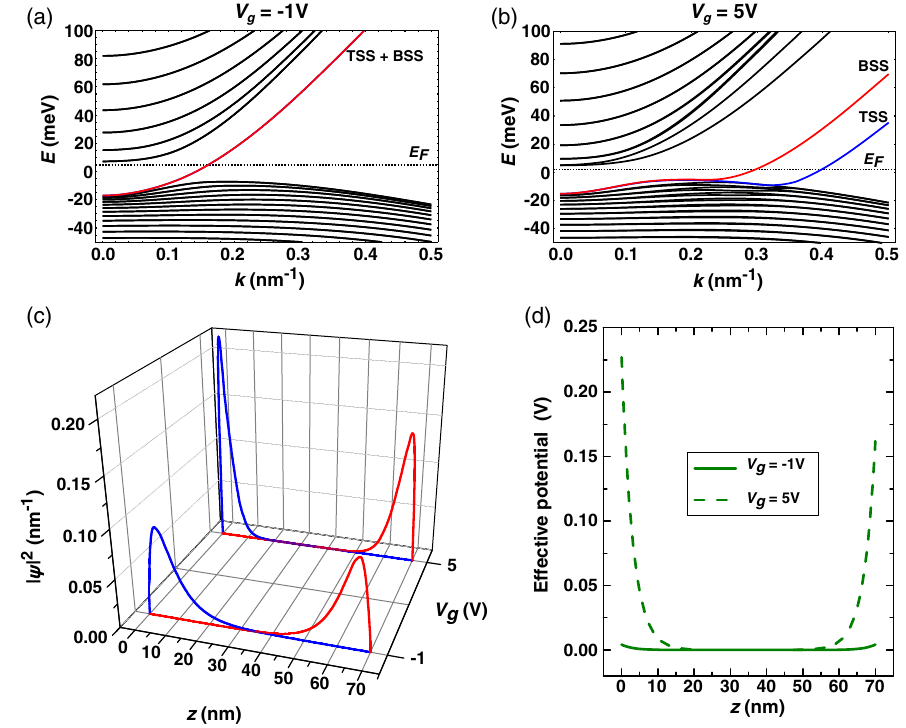
¼ − 1 V ( n ¼ 3 . 5 × 10 11 cm − 2 ) g